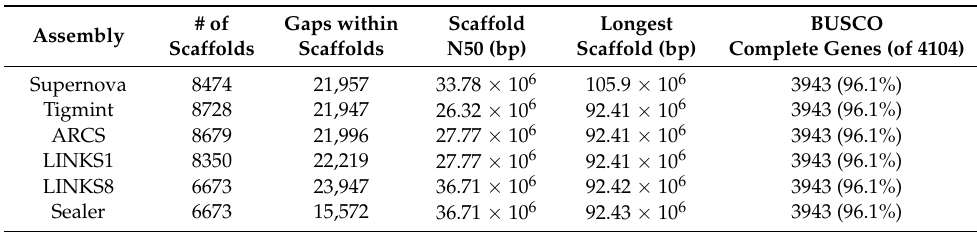
Table 1. Assembly statistics and gene content for the genome sequences reported in this study. Busco: Benchmarking Universal Single-Copy Orthologs.